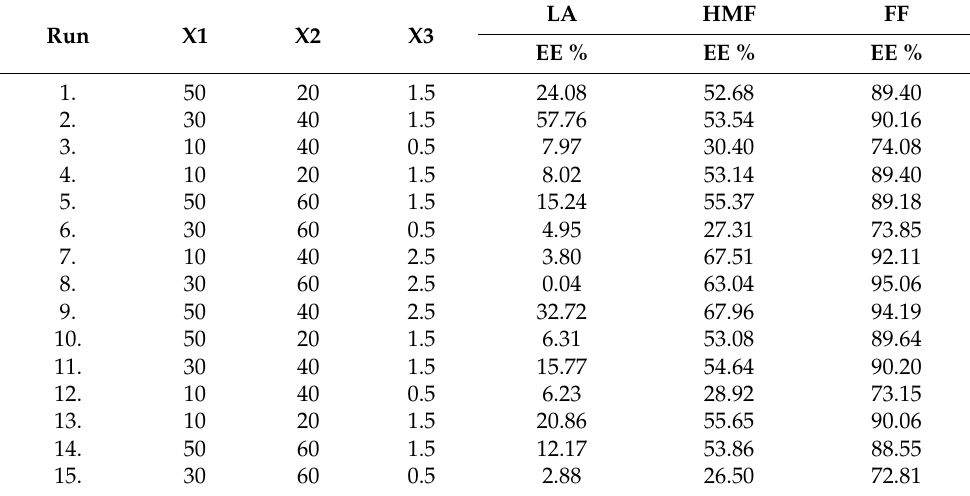
Table 2. Box–Behnken experimental design; X3 is defined as V Cam: OA :V PFB .